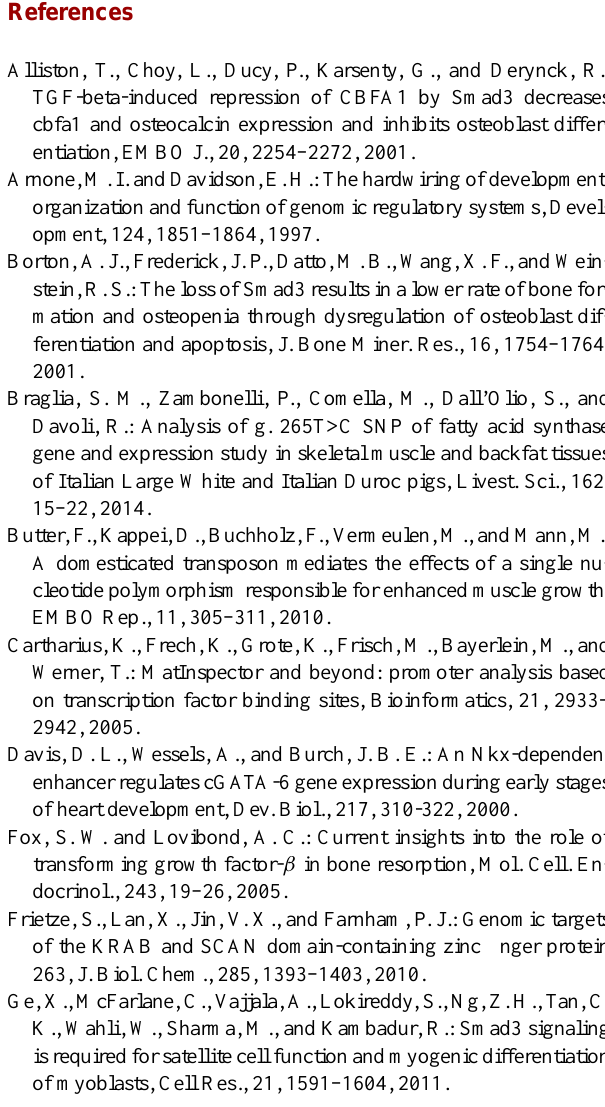
Growth traits (Mean ±